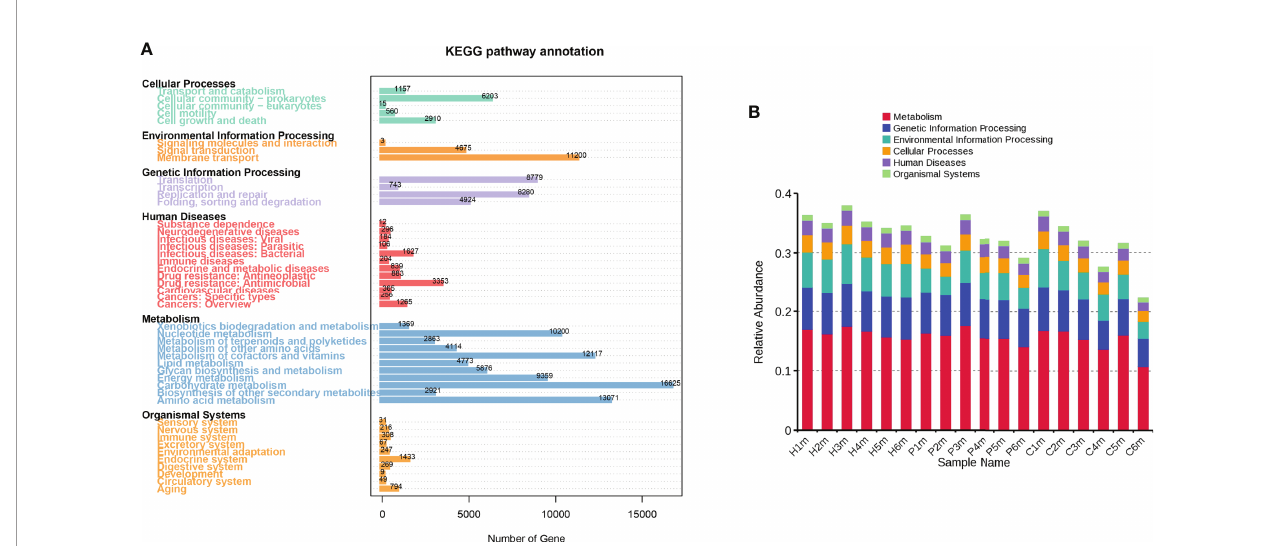
FIGURE 4 | KEGG level 1 pathway annotation according to the genetic data of the oral microbiomes from individuals in the Hm, Cm, and Pm groups. (A) Number of annotated genes in the KEGG database on level 1. (B) Relative abundances of the six pathways in each sample. Hm, healthy individuals; Pm, patients with periodontitis alone; Cm, patients with Crohn ’ s disease and